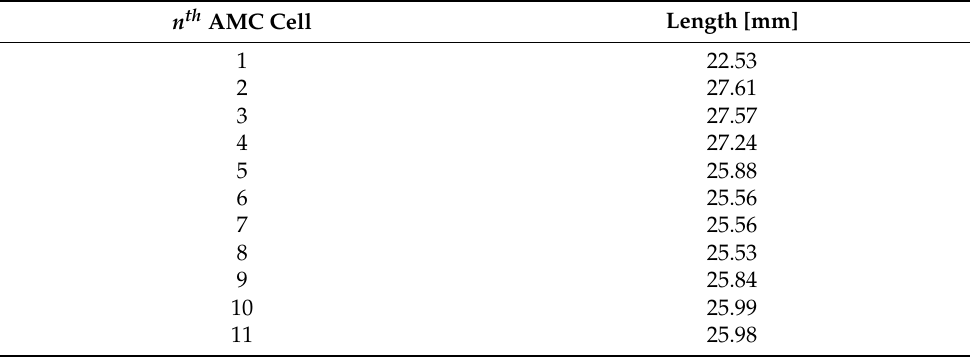
Table 1. Lengths a n (mm) of each AMC cell determined for a scanned beam in θ t = 30 ◦